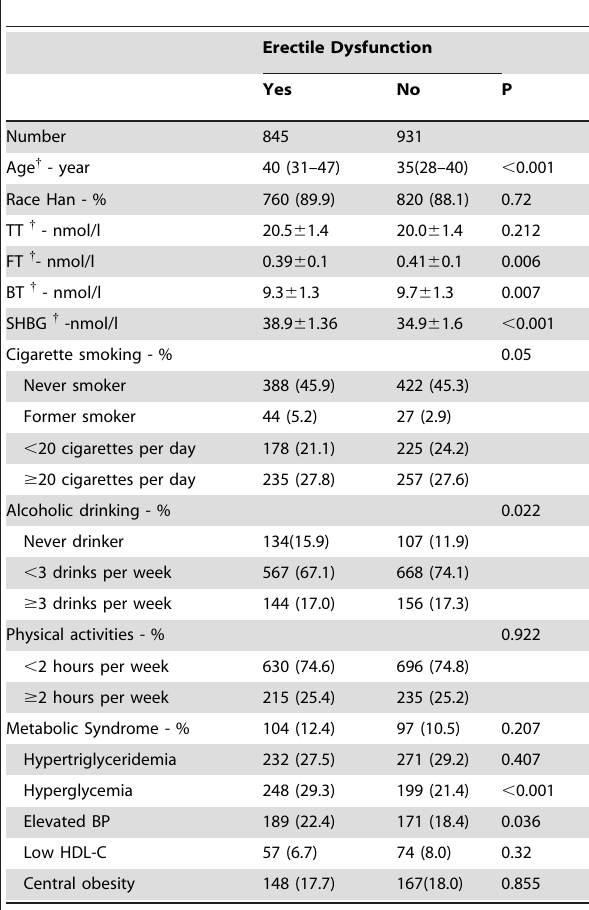
Table 1. Characteristics of the analysis sample at baseline in